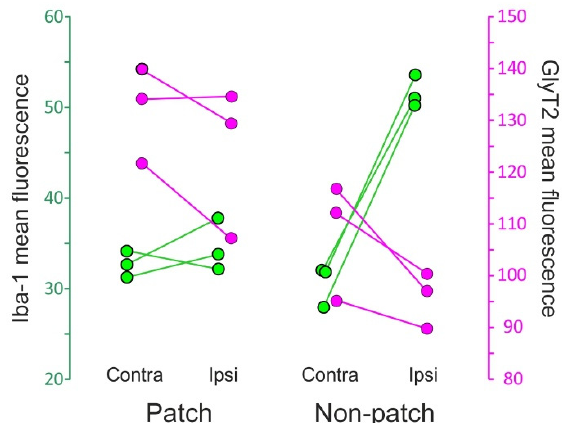
Figure 8. Dot plot of the immunofluorescence of Iba-1 ( green ) and GlyT2 ( magenta ) in lamina III of Sp5C from three CCI-IoN animals. Data represent mean values of 3 sections per case, separately for the GlyT2-strong ‘patches’ and the more moderately immunoreactive ‘non-patch’ zones. Scales are taken from grayscale densitometries with ImageJ (NIH, Bethesda, MD, USA). The diagram shows different combined effects of the nerve injury on each zone: in ‘patches’ the change in Iba-1 immunofluorescence in the side ipsilateral to the CCI is practically nil with respect to the contralateral side, while in ‘non-patch’ or ‘matrix’ zones a pronounced increase is observed. GlyT2, on the other hand, decreases in both zones, apparently more noticeably so in the ‘non-patch’ zones.